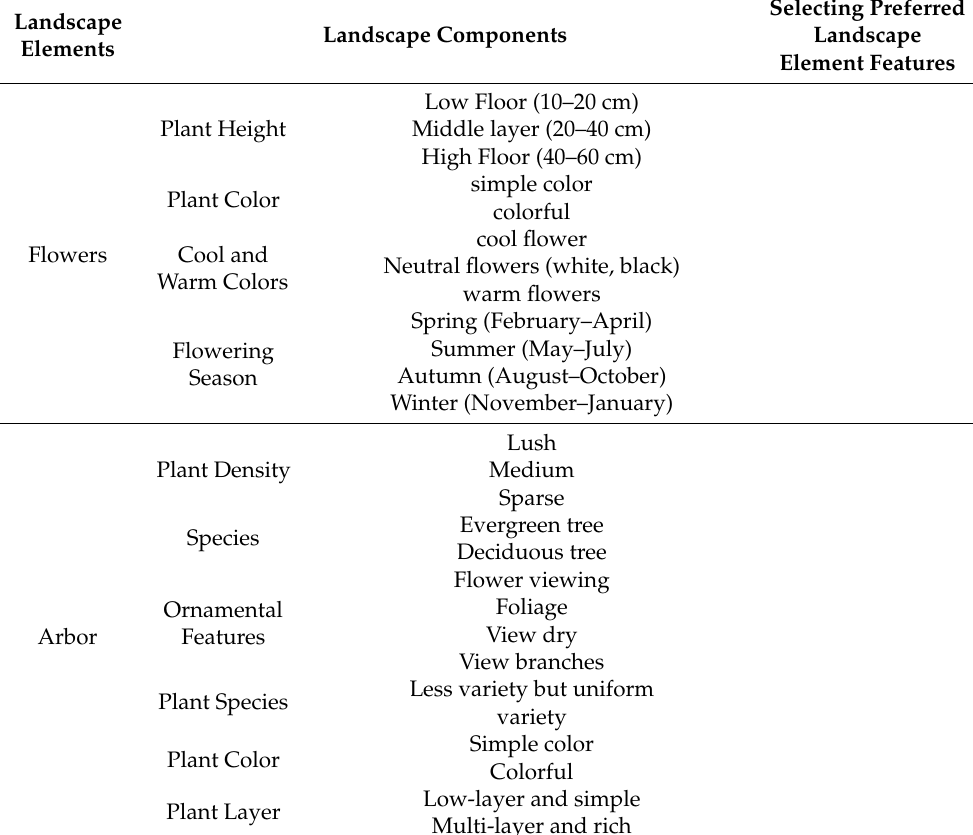
Table A1. Campus Landscape Preference Factor Scales of Laoban